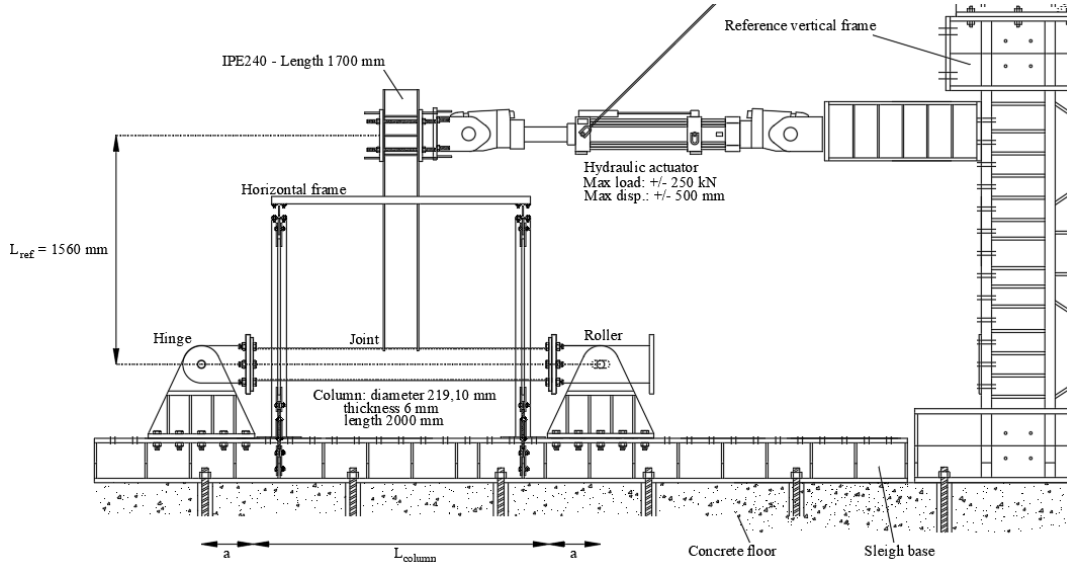
Figure 4. Schematic drawing of the experimental set-up.